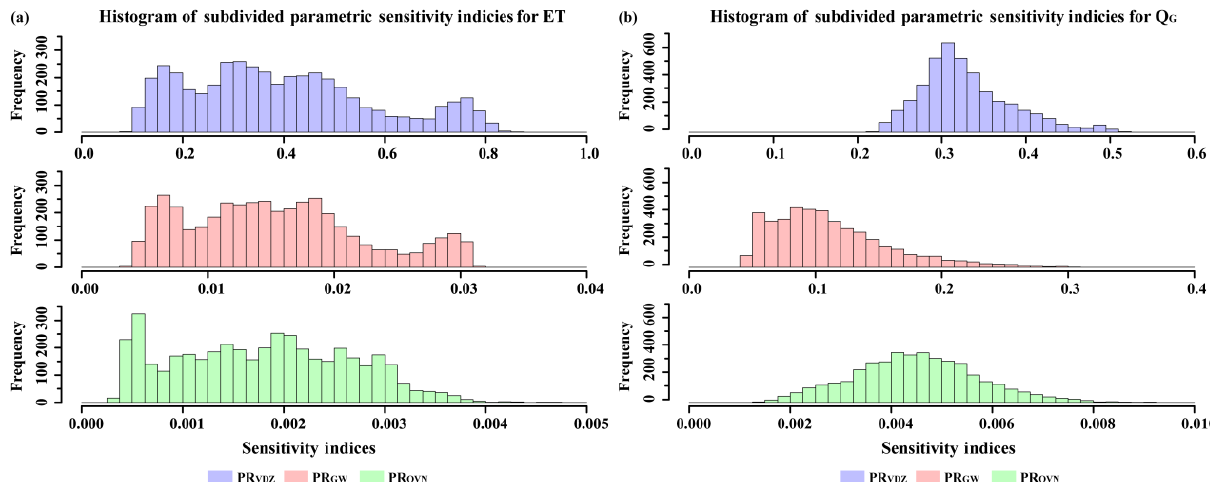
Figure 10. Frequency histograms of subdivided parametric sensitivity indices for spatially averaged results over all 4320 time steps. The results for evapotranspiration (ET) as our output are depicted in (a) , and the results for groundwater contribution to stream flow ( Q G ) as our output are depicted in (b) . PR VDZ represents the vadose zone parameters. PR GW represents the groundwater parameters. PR OVN represents the overland flow parameter.